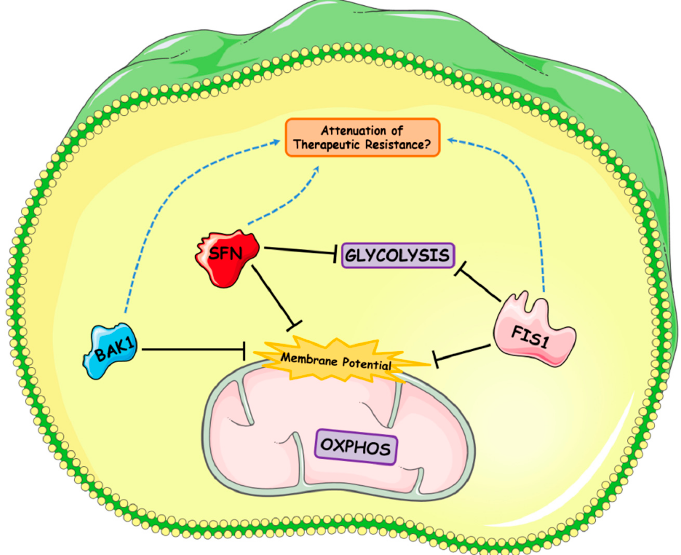
Figure 6. Summarizing the effect of BAK1 , FIS1 and SFN knockdown on mitochondrial function and cellular metabolism. Utilizing qPCR gene microarray screening, we screened 84 mitochondrial genes across the in vitro intestinal metaplasia-dysplasia-adenocarcinoma disease sequence and identified three genes as being differentially expressed: BAK1 , FIS1 and SFN . Moreover, upon further validation we found BAK1 , FIS1 and SFN were differentially expressed across the in vitro and in vivo intestinal metaplasia-dysplasia-adenocarcinoma disease sequence. These three genes were subsequently knocked down in vitro in Barrett’s (QH) and adenocarcinoma (OE33) cell lines to gain some insight into